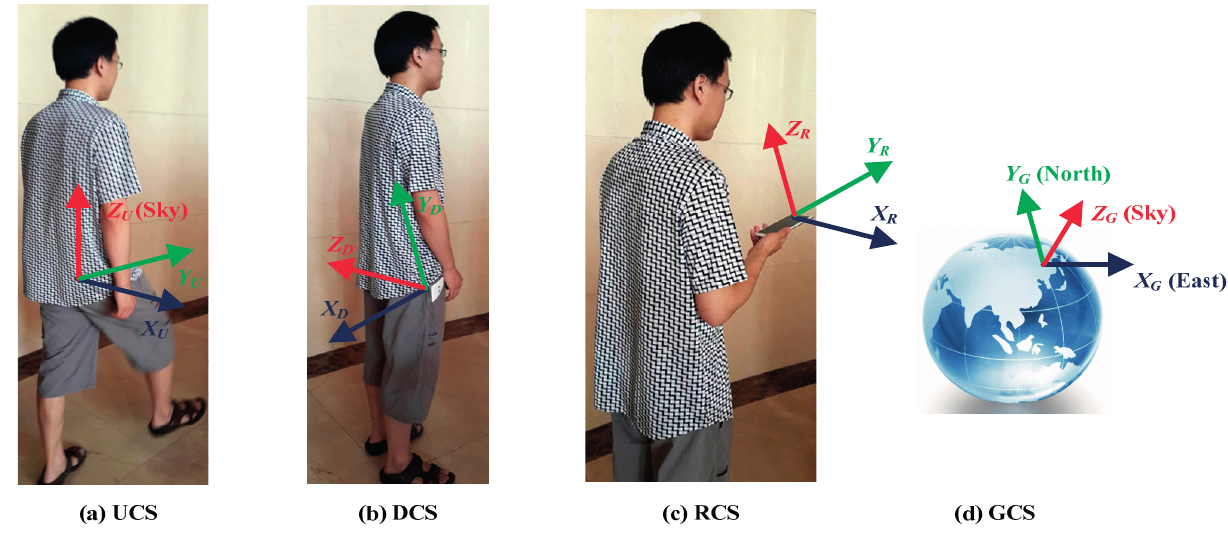
Figure 1. Illustration of the defined coordinate system: ( a ) UCS ( b ) DCS ( c ) RCS ( d )